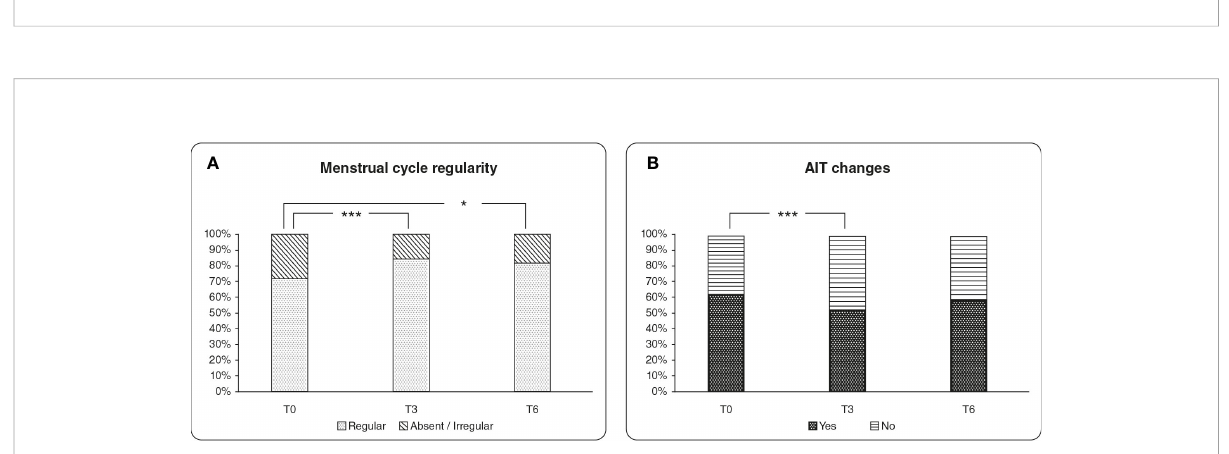
FIGURE 2 (A) Evaluationof menstrual cycle regularity over the treatment period. The graph reports the percentagevalues of patients with regular menstrual cycle compared with patients with absent or irregular menstrual cycle. (B) Evaluationof the AIT changes over the treatment period. The column chart represents the percentagevalues of patients with positive and negative AIT assessment.* = p value < 0.05, *** = p value